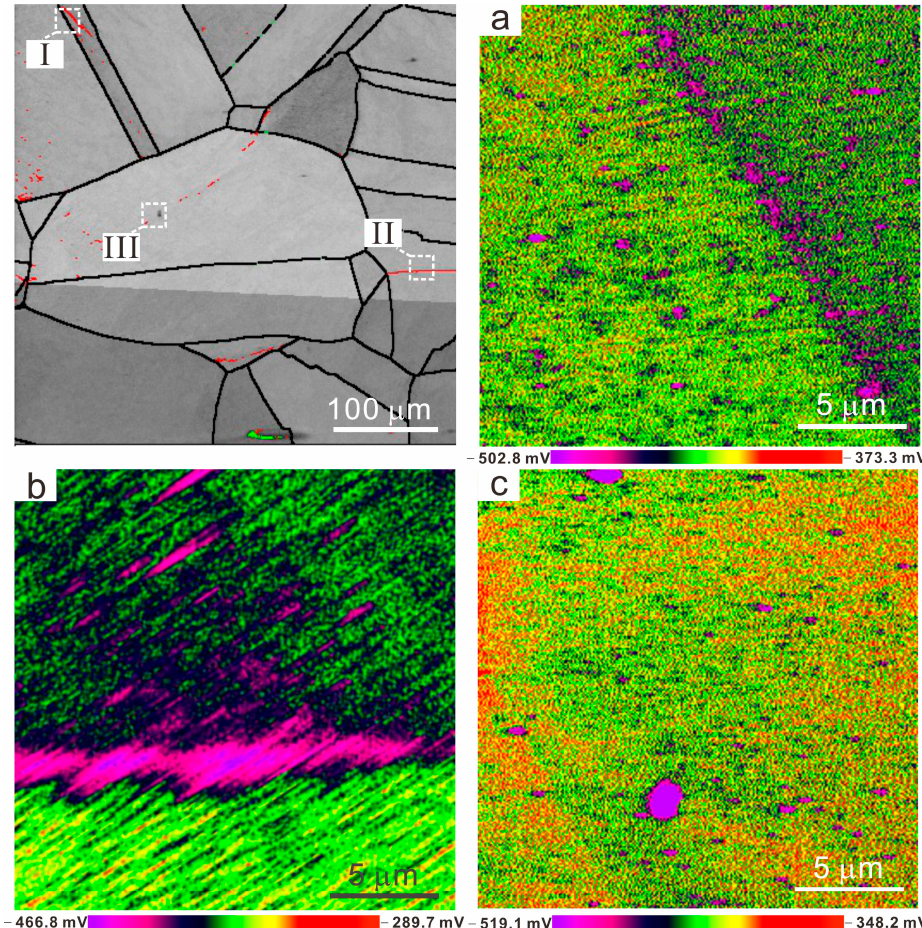
Figure 6. The low-angle grain boundary distribution and the Volta potential of the selected regions Figure 10. deformation. In the EBSD image of 10% deformed copper. The Volta potential of regions I, II and III with different grain boundary distribution were measured to obtain the corresponding potential distribution maps ( a ), ( b ) and ( c ).